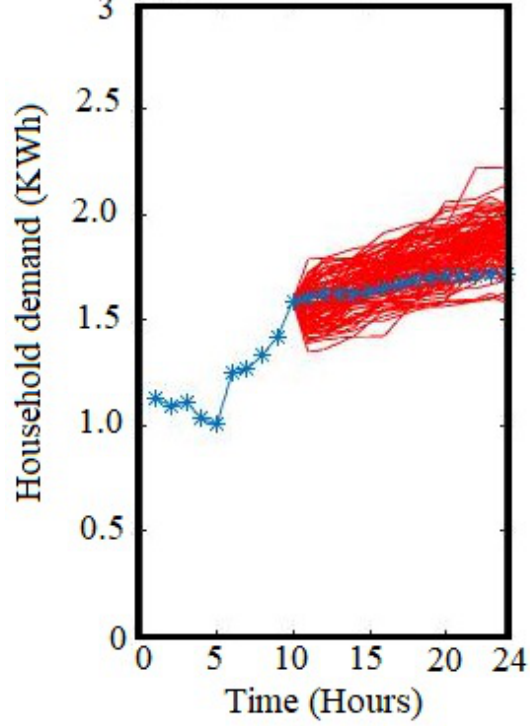
Figure 23. An example of the ensemble forecasts for household